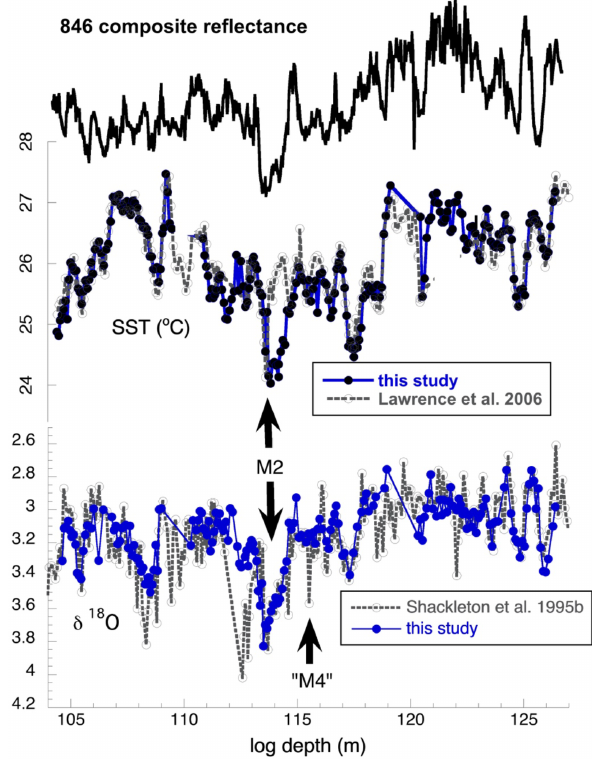
Figure 8. Comparison of alkenone-based SST series of Lawrence et al. (2006) on original composite depth in comparison to detrended and normalized reflectance and GRAPE data. Note the anomalous interval indicated by gray shading where the warm SST values de- part from reflectance and GRAPE values.